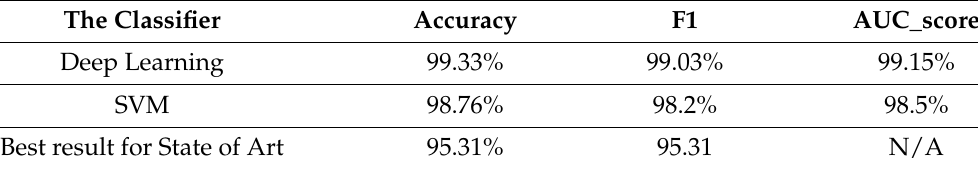
Table 7. Comparison between DL, SVM classifiers and the Related